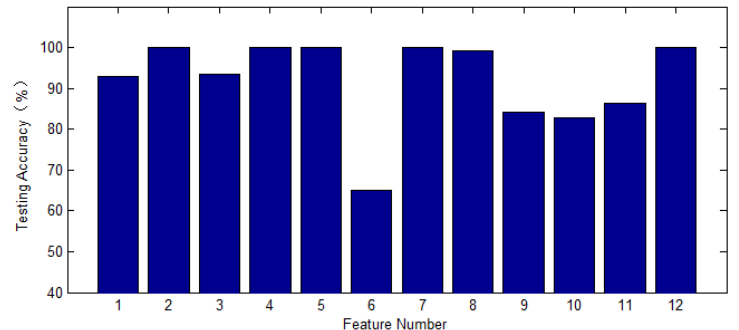
Figure 8. Diagnostic accuracy of fault detection for the rolling bearing. 1: Ma ; 2: Mi ; 3: P k ; 4: A v ; 5: